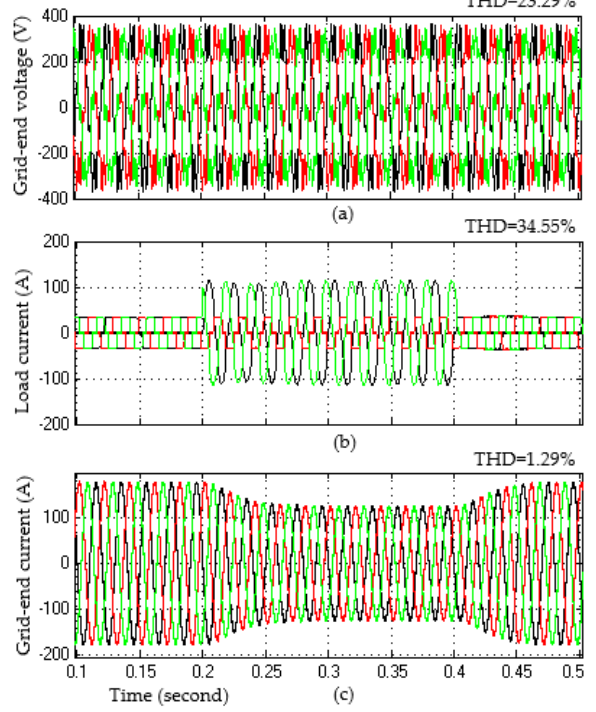
Figure 14. ( a ) Grid-end voltages (THD = 23.29%); ( b ) unbalanced load-terminal currents (THD = 34.55%) under non-ideal voltage waveforms of the wind generation; and ( c ) grid-end current after compensation by the proposed wavelet-based SRF method (THD = 1.26%).